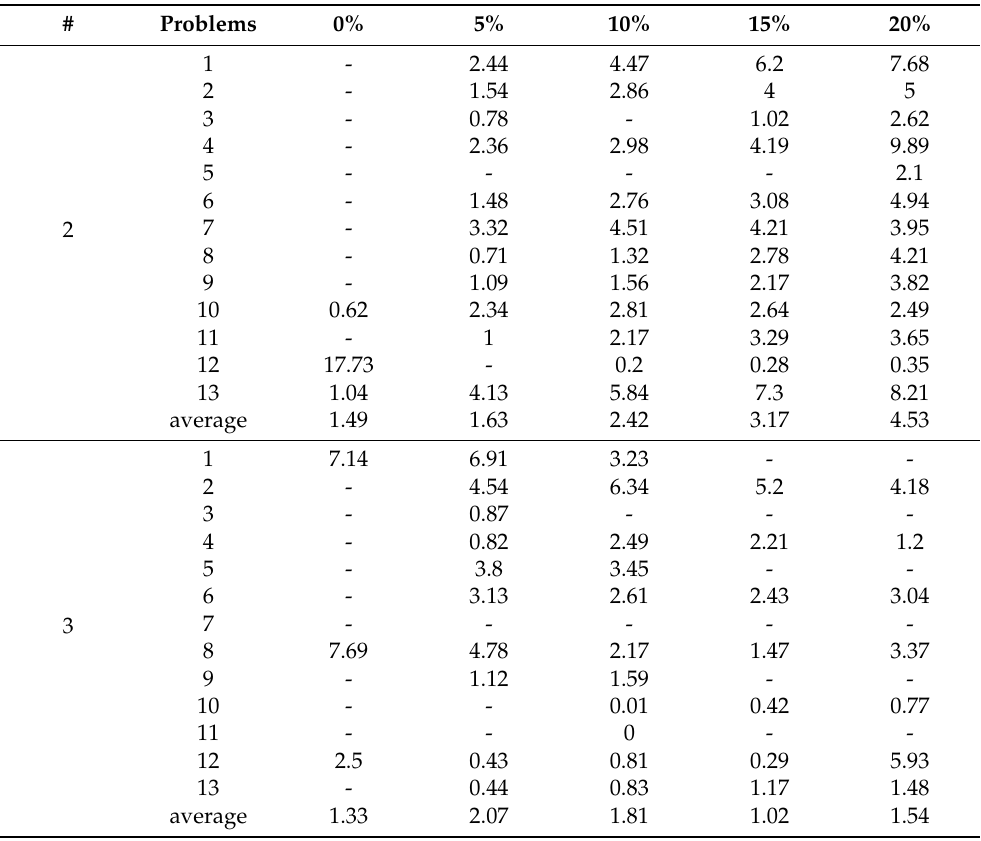
Figure 9. An illustration of task and location sequences for traditional straight assembly lines. Table 3. Improvement in U-shaped production lines (percentage).